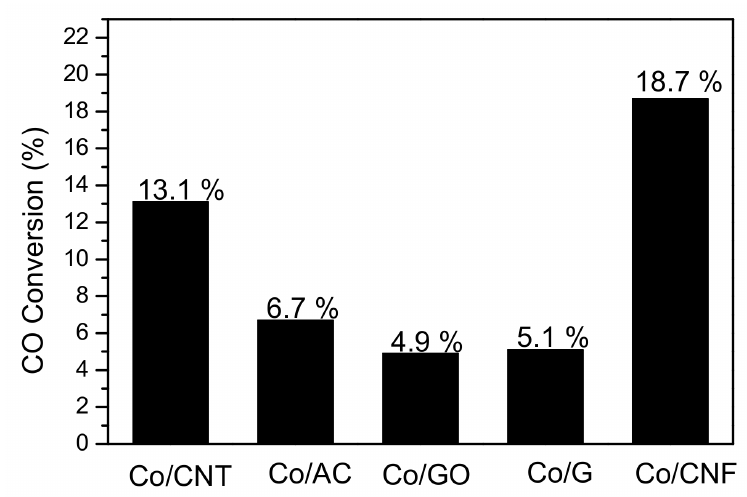
Figure 10. CO conversion of different